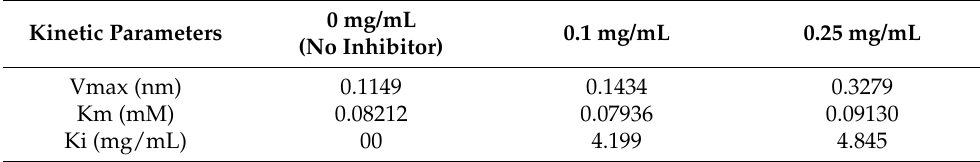
Table 4. Kinetic parameters of hydrolysis of chickpea proteins by alcalase.